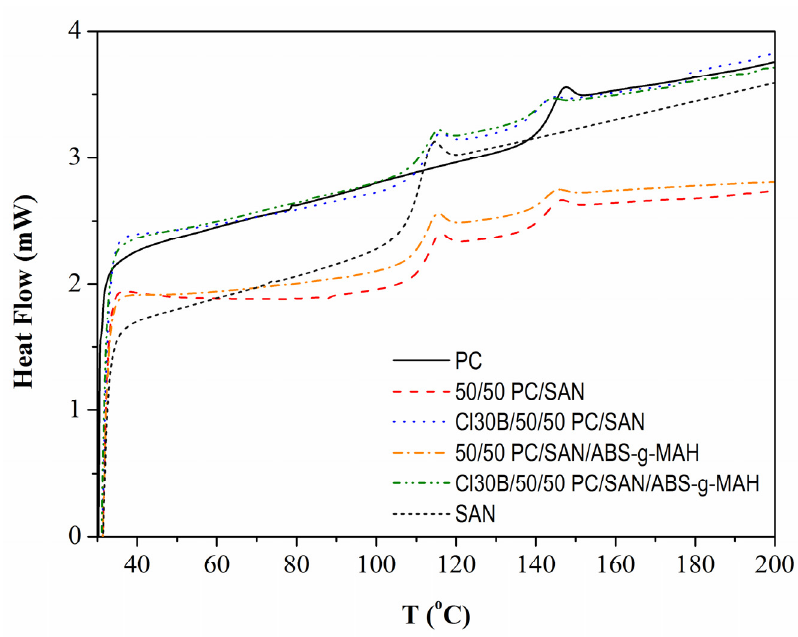
Figure 7. DSC heating curves of PC, SAN and 50/50 w/w PC/SAN blends.